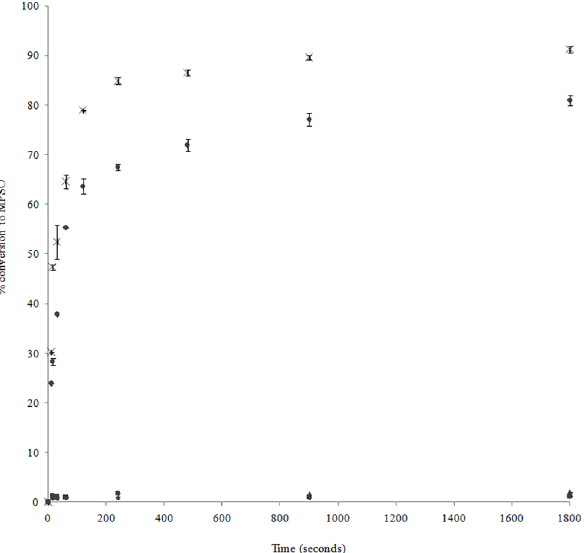
Fig 1. Kinetic study of D and L-DNAzyme catalyzed oxidation of thioanisole. Time courses for the generation of methyl phenyl sulfoxide (MPSO) in the presence of H 2 O 2 at 25°C catalyzed by D-DNAzyme (x) or L-DNAzyme ( ● ). Controls without DNA, “ Control Hemin ” ( ▲ ), and without DNA nor hemin, “ Control H 2 O 2 ” ( ■ ), were also